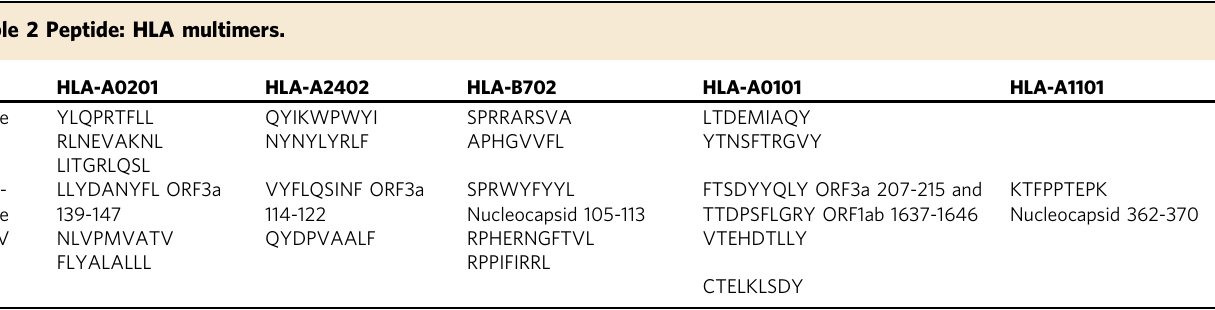
Table 2 Peptide: HLA